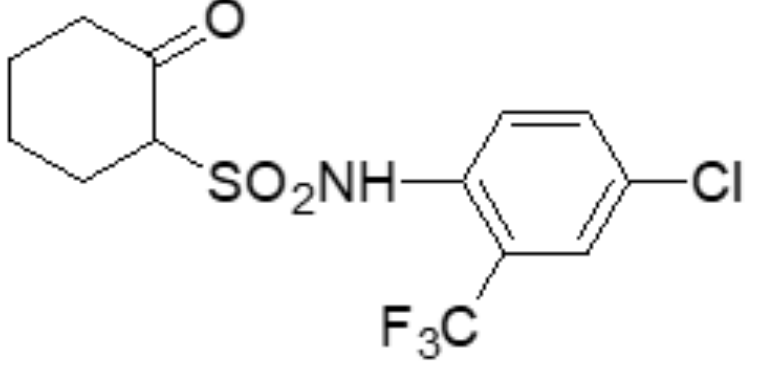
Figure 1. The chemical structure of L13 .